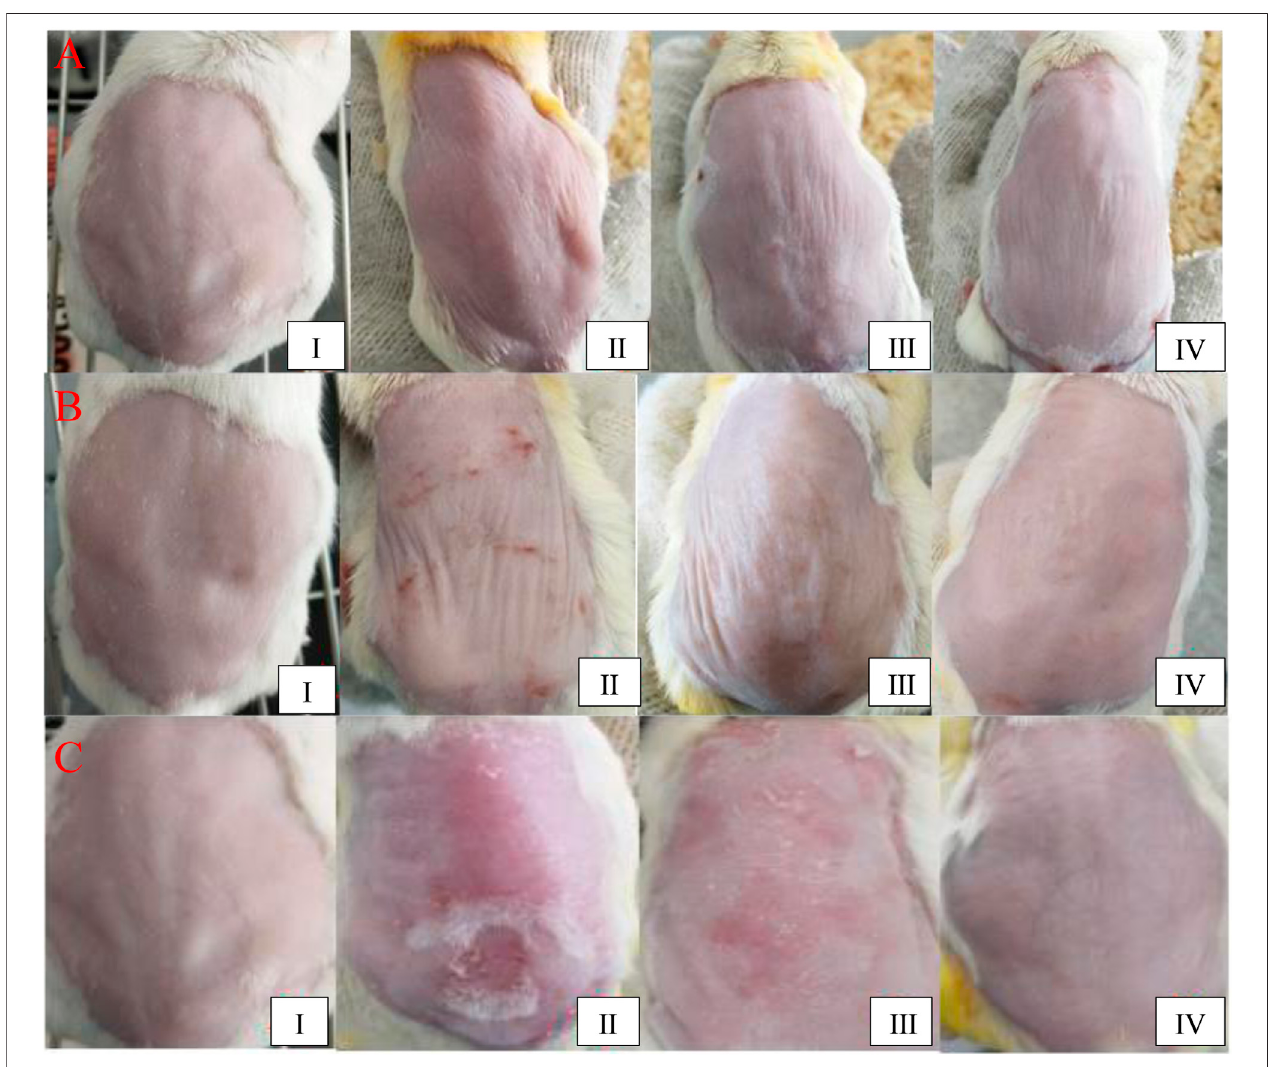
FIGURE 2 | Macroscopic evaluation of the dorsal skin. UV irradiation for 2 weeks (A) ; 6 weeks (B) ; and 12 weeks (C)